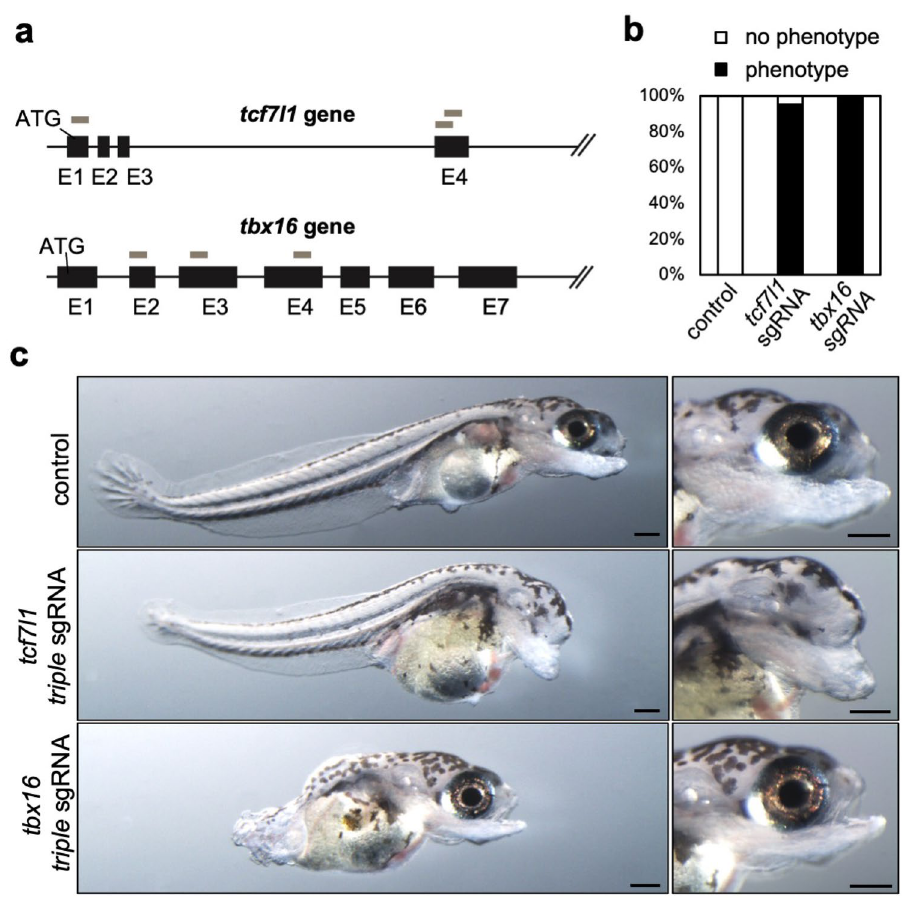
Figure 2. Triple-target CRISPR efficiently disrupts the genes involved in morphogenesis. ( a ) A schematic representation of tcf7l1 and tbx16 loci (black box: exon, ATG: start codon) and three sgRNA target sites (gray box). ( b ) The percentage of embryos uninjected (control, n = 63) or injected with triple sgRNA targeting tcf7l1 (n = 21) or tbx16 (n = 28), respectively, showing expected phenotype (phenotype) at 14 dpf. ( c ) 14 dpf embryos uninjected (control) or injected with triple sgRNAs targeting tcf7l1 and tbx16 , respectively. Scale bar: 100